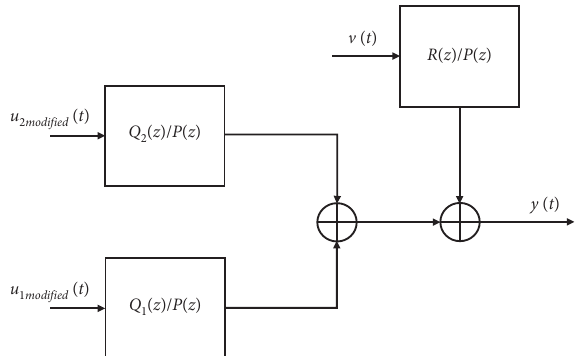
( t ) and u ( t ) to generate u 1 2